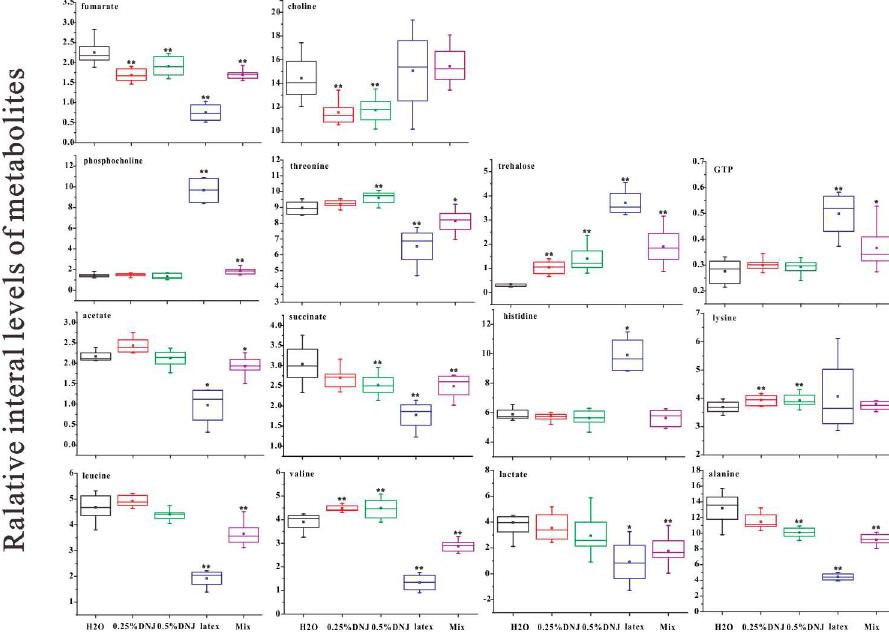
Fig 4. Box plots of relative integral levels of main metabolites in midgut samples of different groups of Eri silkworms. * p < 0.05 and ** p < 0.01 respectivelyindicatesignificantdifferences and extremely significantdifferences comparedwith the control group.